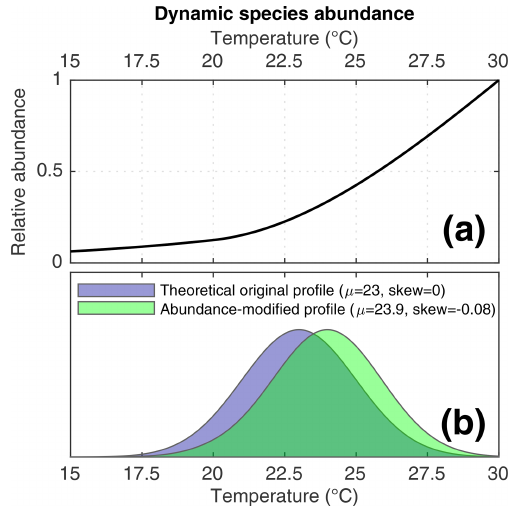
Figure 2. (a) The dynamic species abundance function applied to some of the simulations in this study. (b) A theoretical example of how the dynamic species abundance would bias recording of SST by individual foraminifera. In purple, a normally distributed theo- retical SST profile. In green, the signal that would be recorded by a species affected by the dynamic species abundance